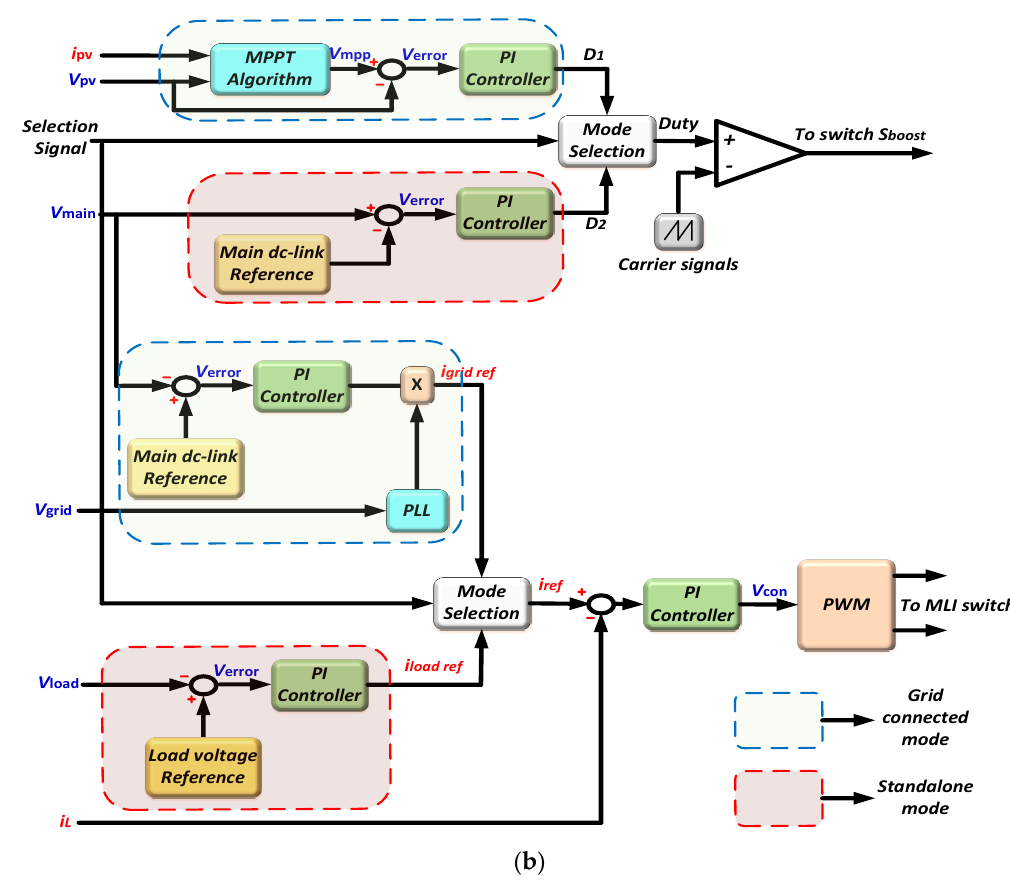
Figure 21. ( a ) PV module CHB MLI applying a module-integrated converter (MIC) concept, ( b ) control scheme for the proposed MLI PV PCS [166].